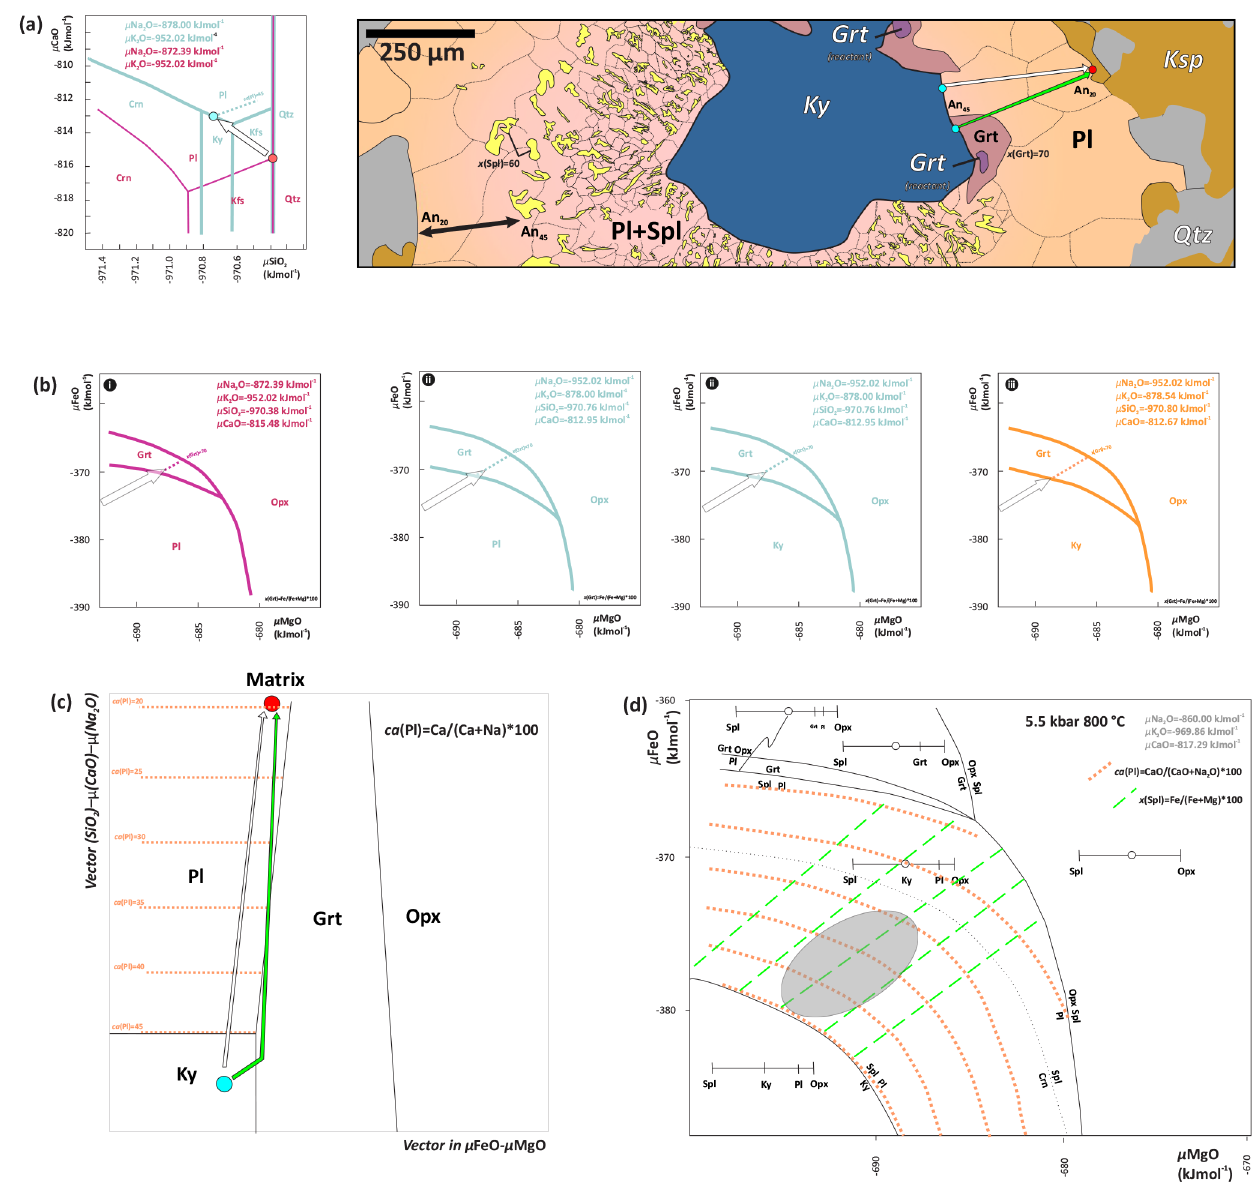
Figure 15. Chemical potential relationships governing the development of a corona after kyanite (after Štípská et al., 2010). All component chemical potentials referred to apply to those within the phases in the local equilibria under consideration. (a) Calculated µ (SiO 2 ) – µ (CaO) diagrams in the NCKAS system for the matrix (red lines) and the kyanite boundary (light blue lines). Gradients in the chemical poten- tials from the matrix to the kyanite–plagioclase boundary are represented by a vector in µ (SiO 2 ) – µ (CaO)– µ (Na 2 O) space. (b) Superim- posed µ (MgO) and µ (FeO) variations on the µ (SiO 2 ) – µ (CaO)– µ (Na 2 O) vector from panel (a) : (i) for the matrix, (ii) for the plagioclase– kyanite boundary and (ii) inside kyanite. The topology shows garnet and orthopyroxene fields, while spinel is metastable. Garnet compo- sitional isopleths x (Grt) are plotted within the garnet stability field. The arrow is a vector coincident with the x (Grt) = 70 isopleth, where x (Grt) = Fe / (Fe + Mg) × 100. (c) Phase topology obtained by manual combination of the calculated phase relations along a slice at approx- imately fixed µ (MgO) /µ (FeO) (along x(g) = 70) from panel (b) , with the calculated phase relations along the vector µ (SiO2)– µ (CaO)– µ (Na2O) from panel (a) , contoured with compositional isopleths ca(pl). The dashed arrow shows a path from kyanite across garnet and plagioclase towards the matrix. (d) µ (FeO)– µ (MgO) diagrams along the ca (Pl) = 45 line calculated at 800 ◦ C and 5.5kbar. SiO 2 and Al 2 O 3 are immobile. Fields are labelled with Al 2 O 3 –SiO 2 bar diagrams and contoured for x (Grt), x (Spl) and ca (Pl). The grey ellipse shows regions of plagioclase–spinel symplectite where mineral compositions correspond to observed values ( ca (Pl) = 35–45mol% and x (Spl) = 60–63).